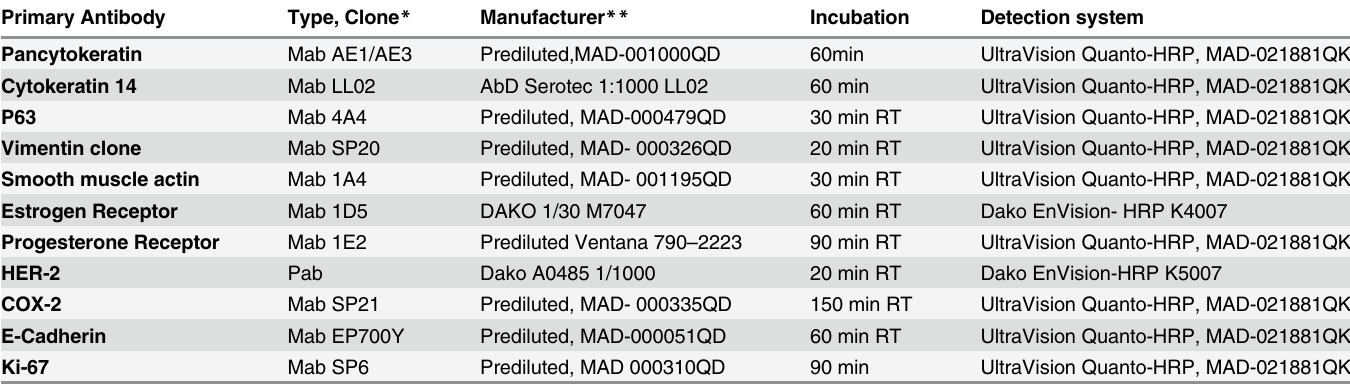
Table 1. Technical data of specific antibodies and peroxidase-developing systems for immunohistochemistry. Primary